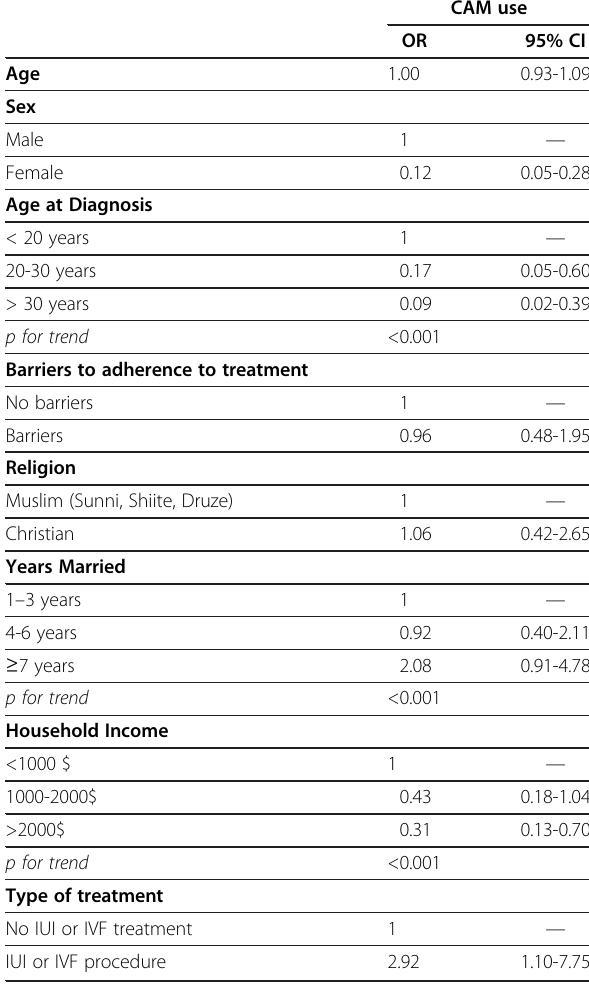
Table 3 Multivariate Logistic Regression Model with OR estimates and 95% CI for the association between demographic and fertility-related factors and the use